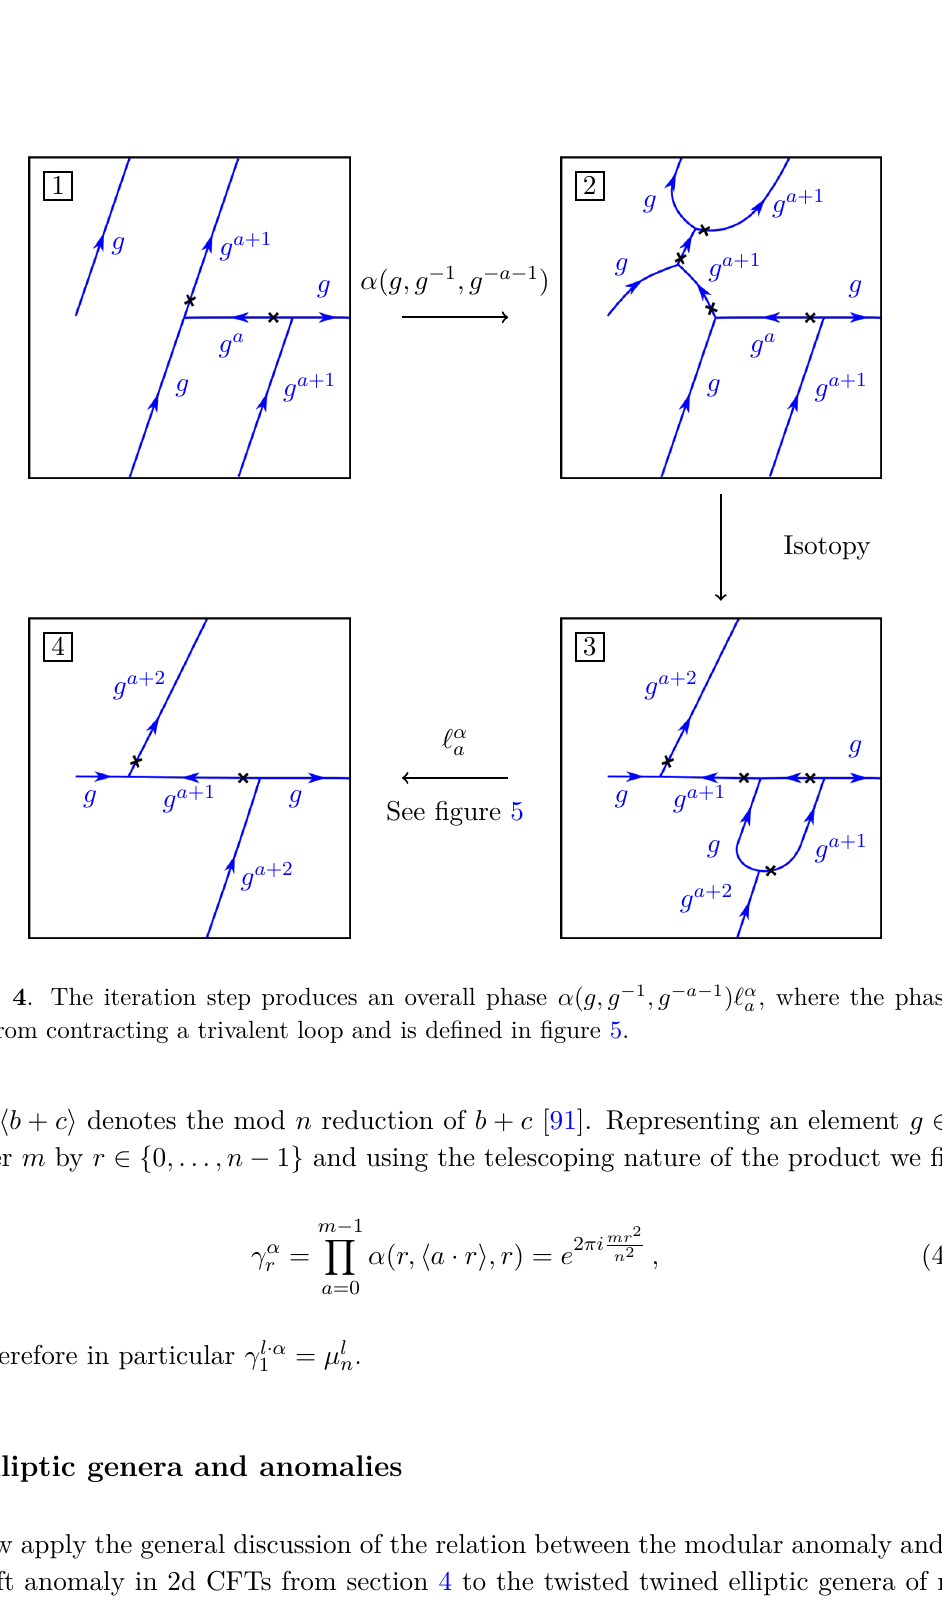
Figure 4 . The iteration step produces an overall phase α ( g, g − 1 , g − a − 1 ) ‘ α arises from contracting a trivalent loop and is defined in figure